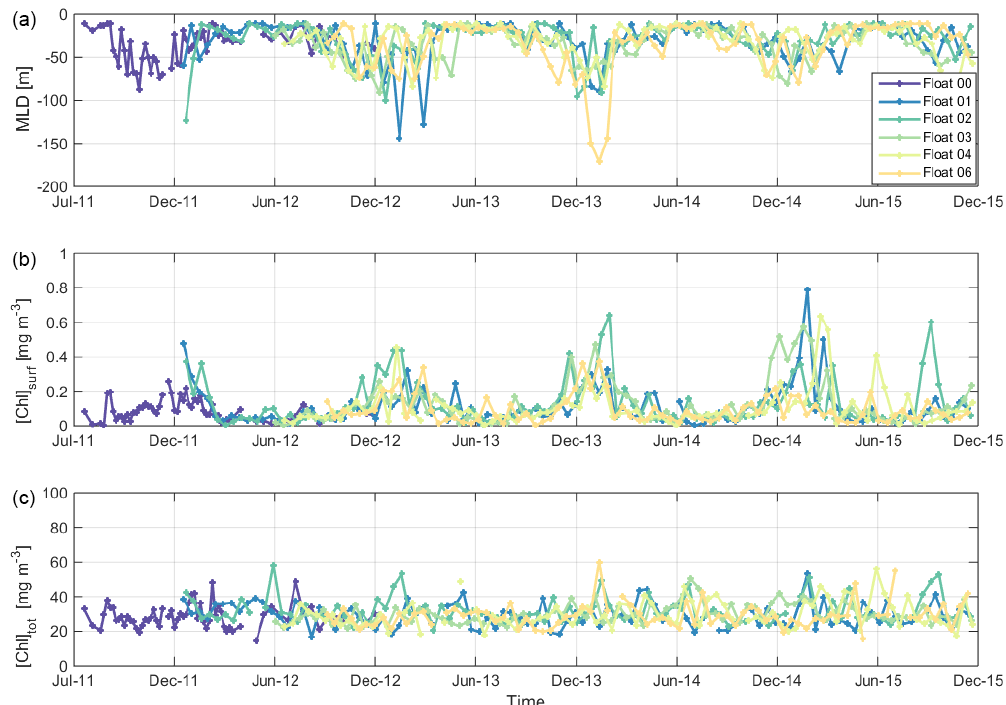
Figure 4. Float time series of the (a) mixed-layer depth, (b) mean surface chlorophyll concentration, and (c) integrated content of chlorophyll over the 0–350m